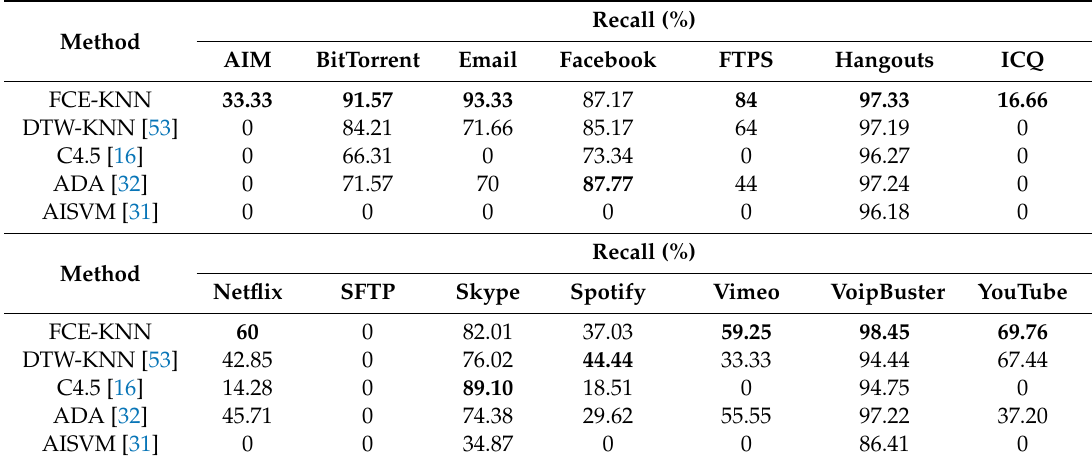
Table 6. Recall comparison between FCE-KNN and other algorithms for identifying application type of encrypted network flows.